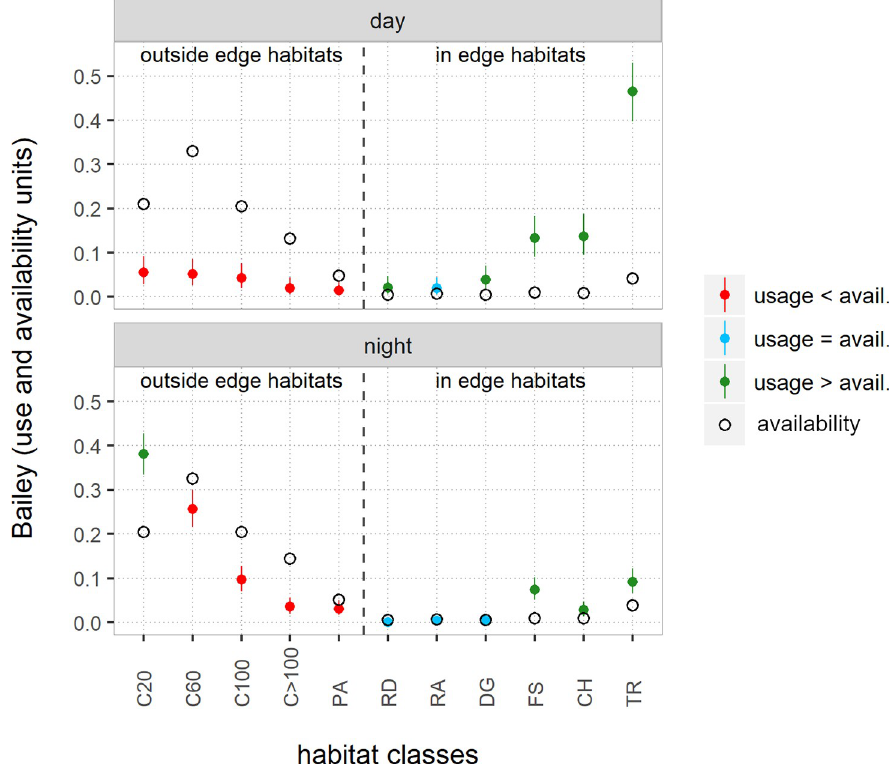
Fig 1. Habitat use-availability analysis [50, 52]. Availability proportions of habitat classes (open circles) and percentage of use by leverets in the daytime (day) and at nighttime (night), each combined for the two seasons (solid circle with whiskers for the Bailey’s 95% confidence limits: red = ‘use < availability’, blue = ‘use = availability’, green = ‘use > availability’). Linear habitat classes (edge) are separated from areal habitats (non-edge, i.e., crop fields and